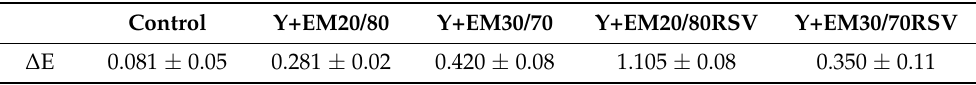
Table 1. Colour difference ( ∆ E) observed when relating each fresh sample with its counterpart after 1 month of storage in a fridge.